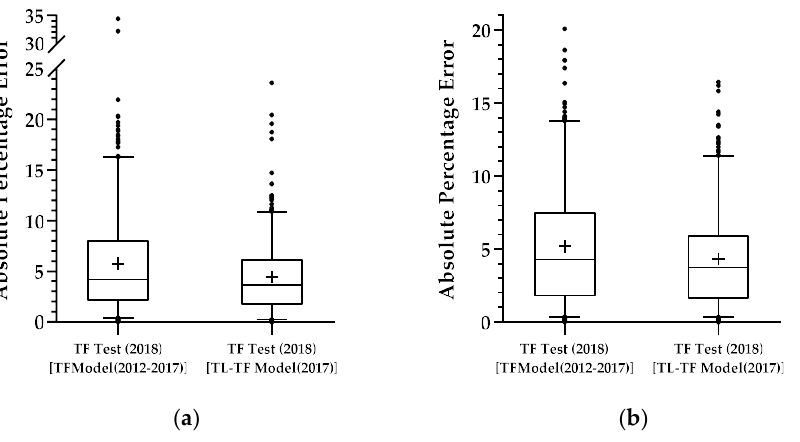
Figure 8. Absolute percentage error of each TF Test 2018 when applied to both created models: ( a ) sugar measurements; ( b ) pH measurements.